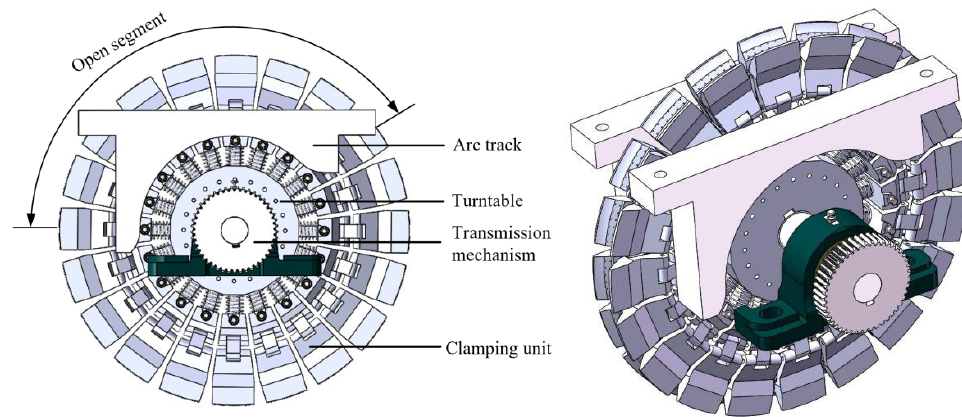
Figure 7. Segmented shrimp clamping mechanism.